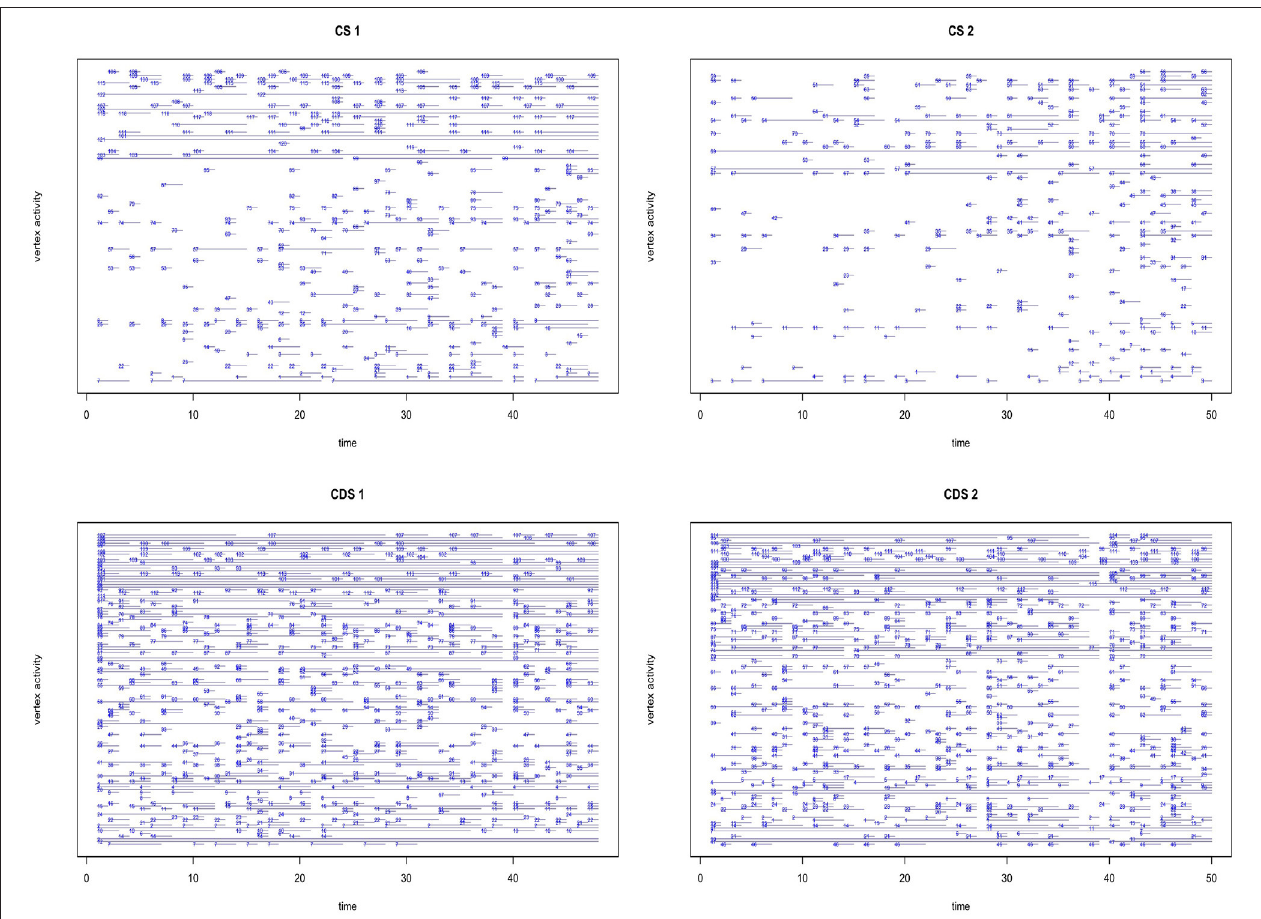
FIGURE 3 | Inflected patterns activity throughout the entire time range in the data. Each line represents the time in which a node is active in the network. Nodes are represented by the numbers at the beginning of each line (root nodes have been removed in order to increase